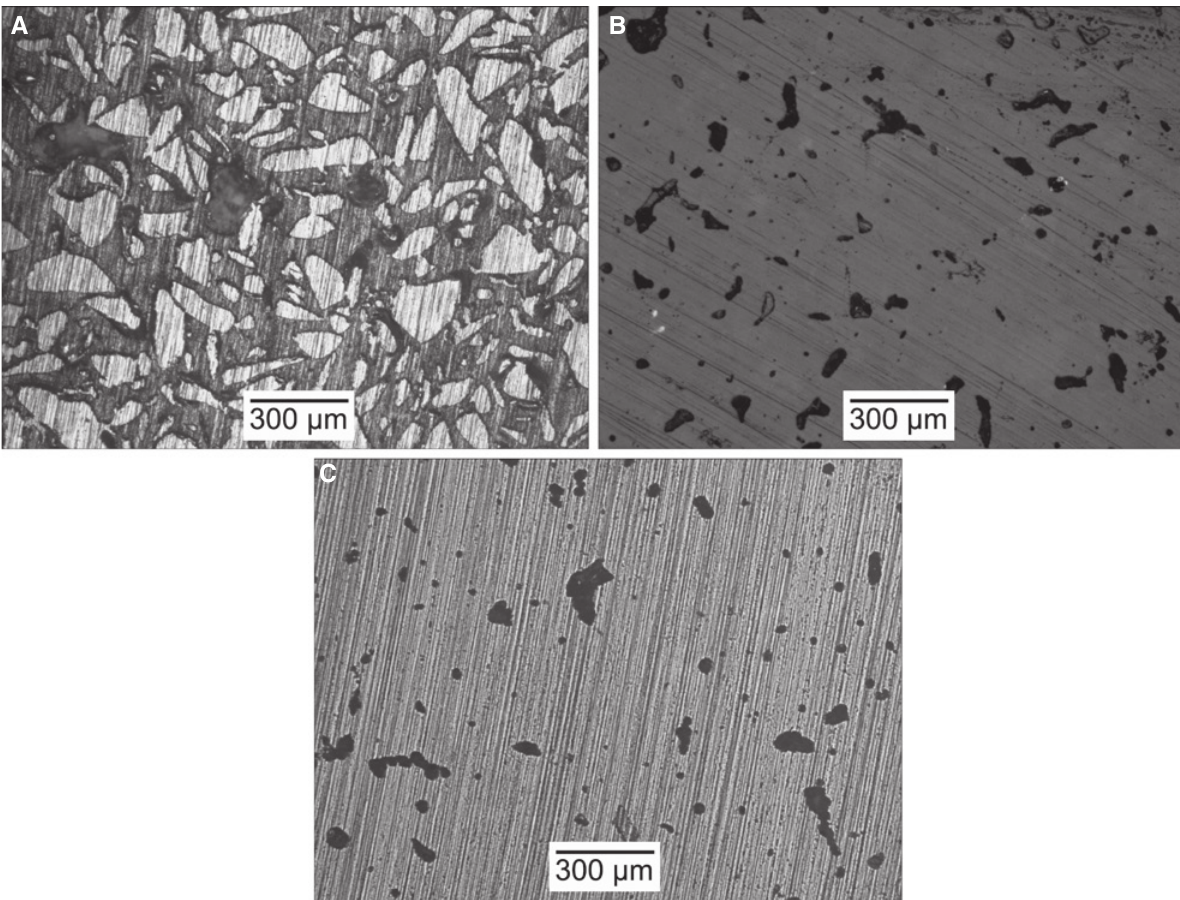
Figure 4: Micrographs of MG80 recycled glass sintered for 15 min at (A) 725 ° C, (B) 775 ° C, and (C) 800 ° C.